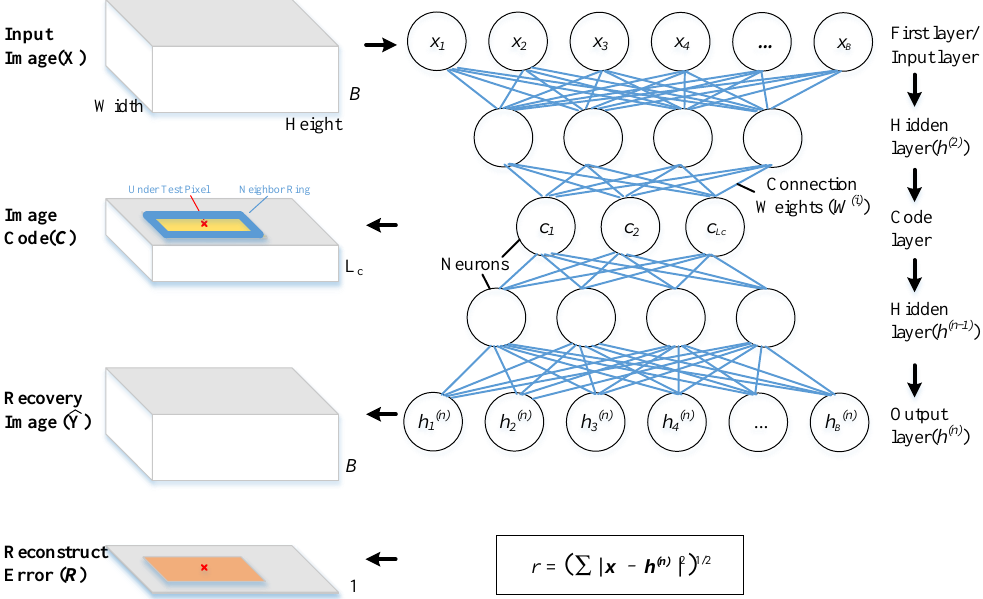
Figure 1. Auto-encode deep learning model structure and data relationship with HSI dataset. Window height and Window width stand for the height and width of the input image respectively. L c stands for the length of the code. B stands for spectral band numbers. r denotes the reconstruction error of each pixel, r ∈ R . n is the number of network layers. i ∈ [ 1, n ] , i is a